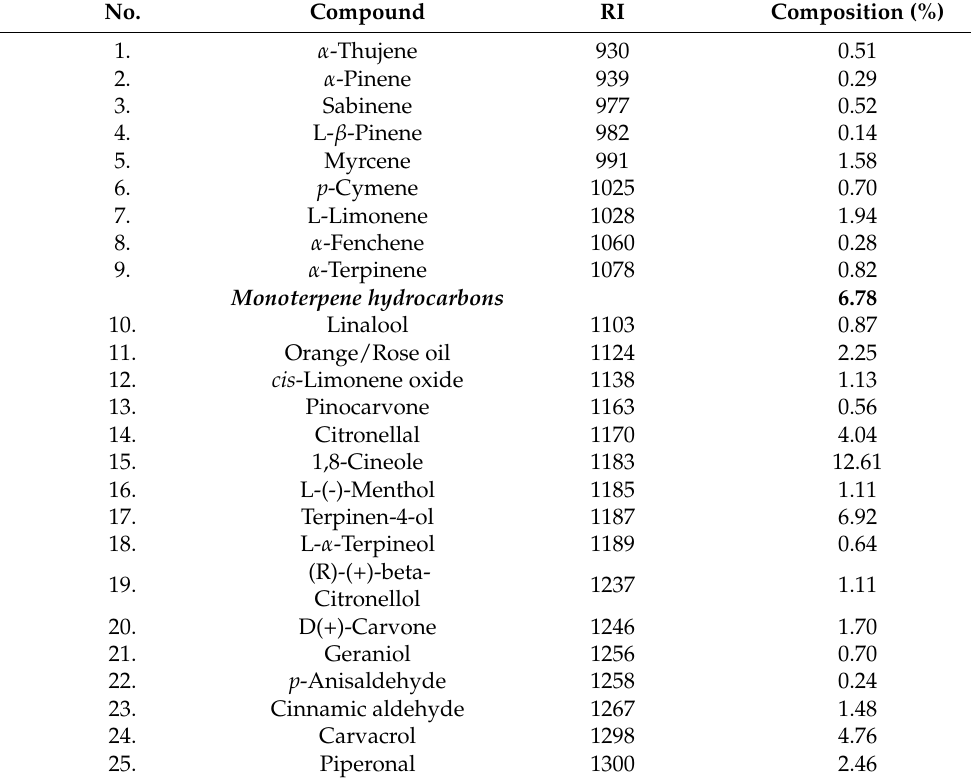
Table 1. The chemical composition (%) of L. nobilis L. leaf